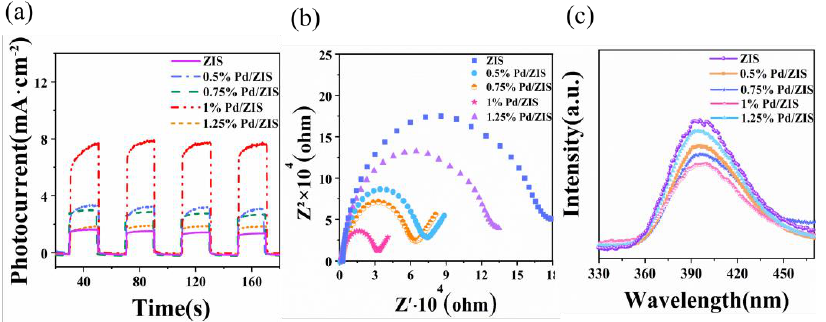
( c ) PL spectra of ZIS and